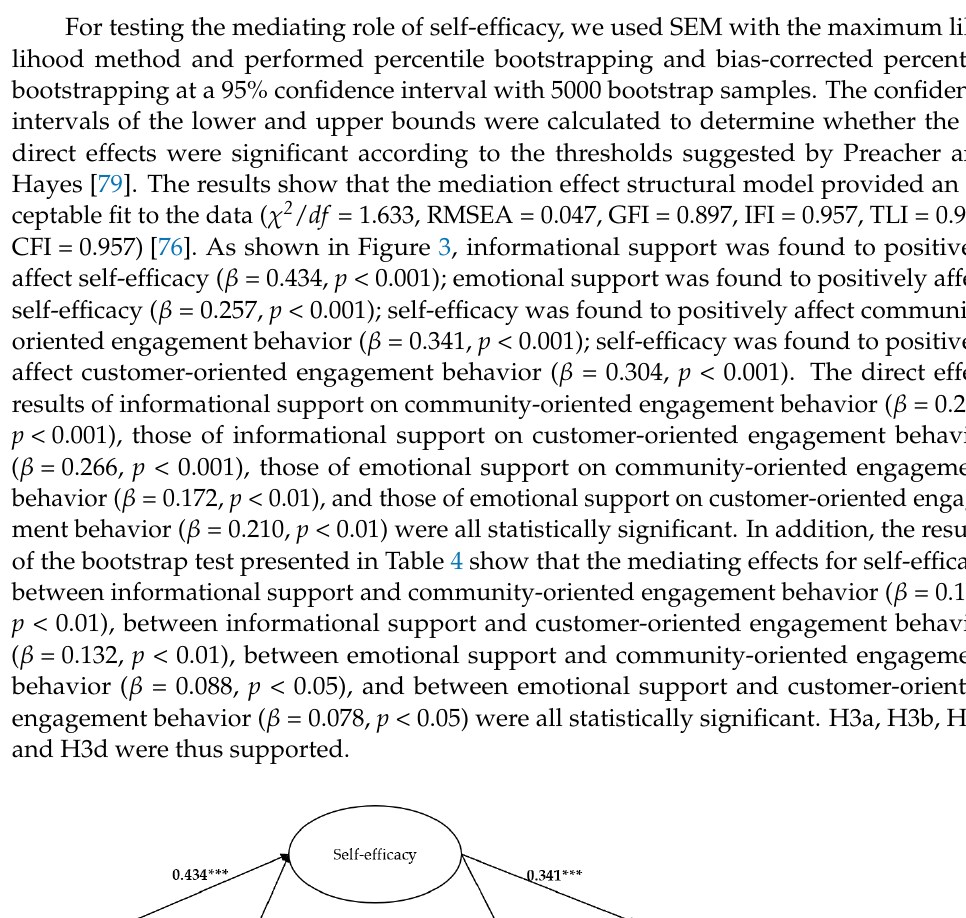
Figure 2. Direct effects of informational/emotional support on community-oriented/customer- oriented engagement behavior. Note: N = 293, *** p < 0.001.